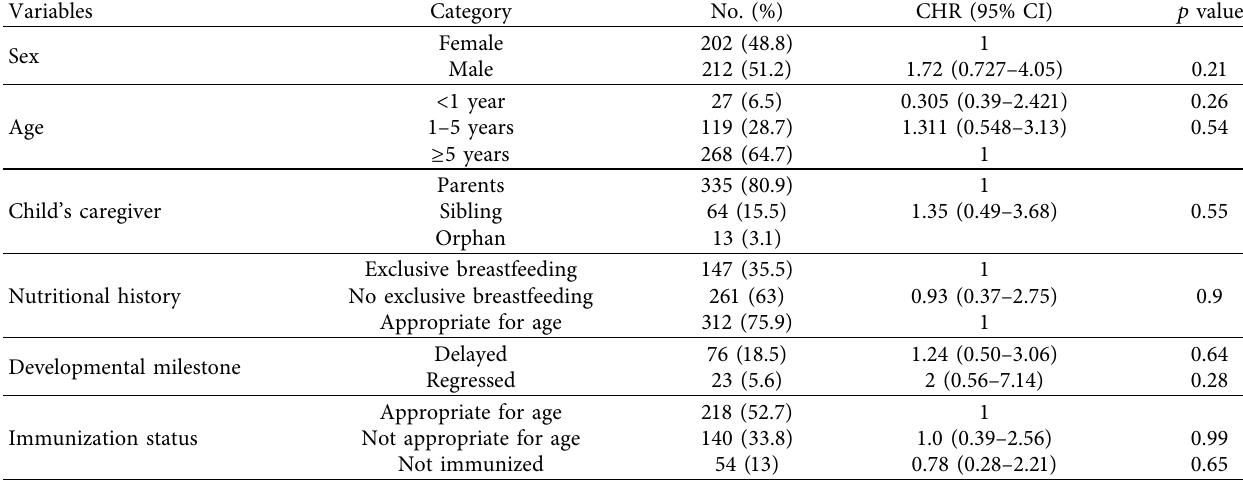
Table 3: Bivariable Cox regression analysis for sociodemographic determinants of survival among children started ART at public health facilities between January 1, 2011, and December 30, 2015, at Shashamene town, Oromia Region, Ethiopia.